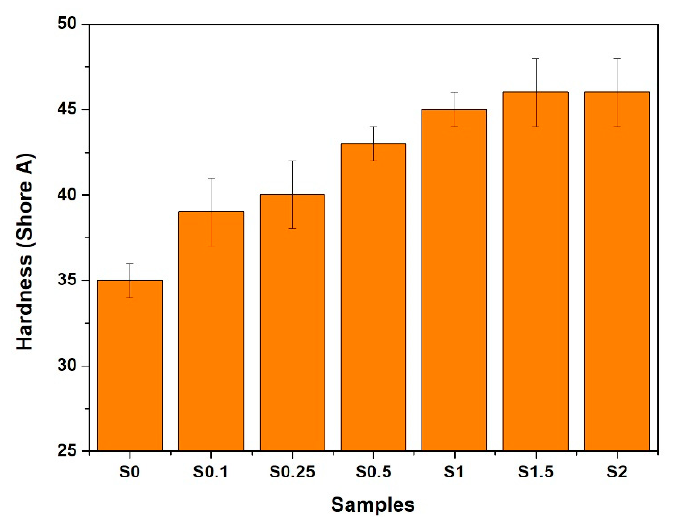
Figure 5. The variation in hardness in NR foams containing different content of GNS/CNT hybrid .